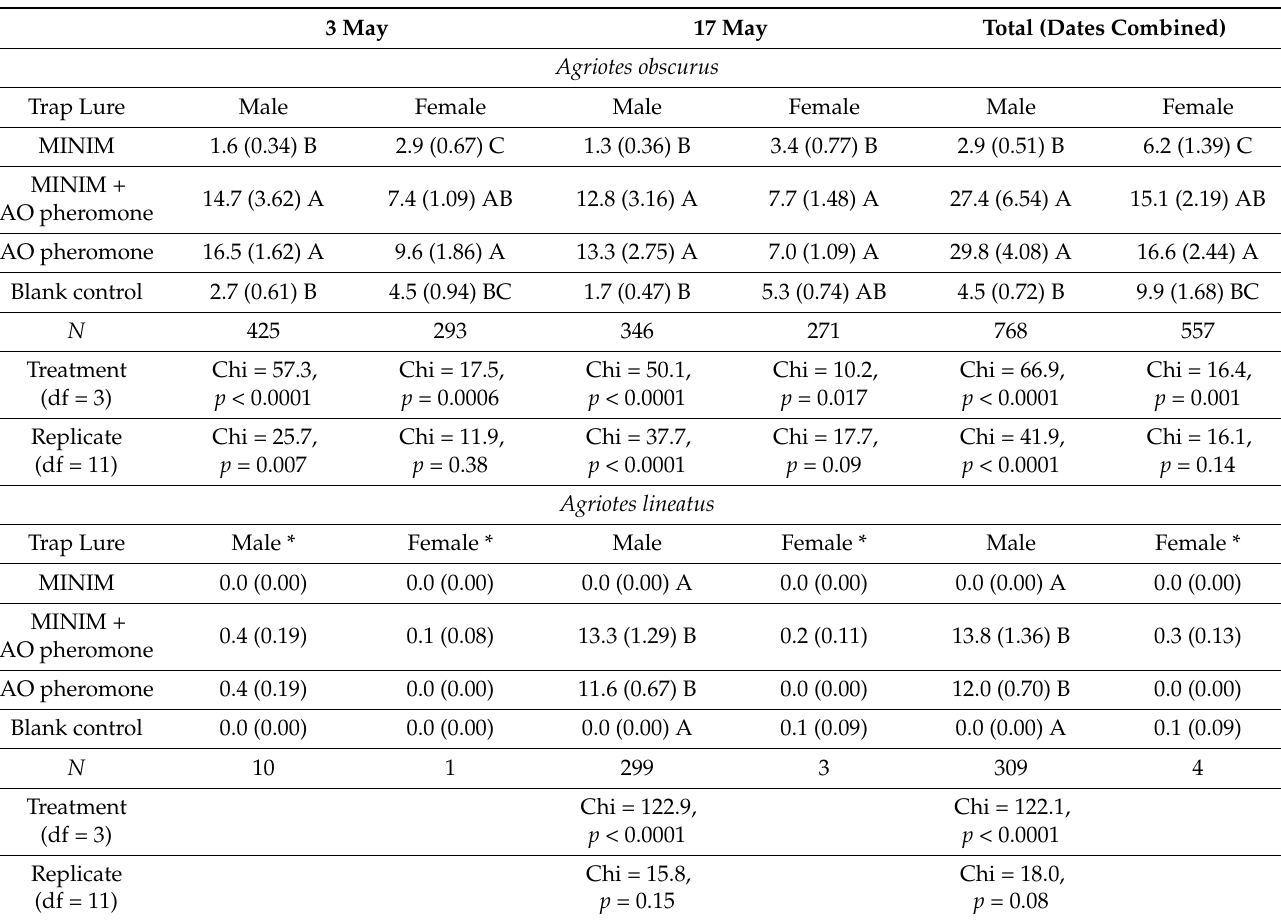
Table 1. Capture of Agriotes obscurus (AO) and A. lineatus (AL) male and female click beetles in traps baited with MINIM, a plant-derived attractant to A. brevis , and/or A. obscurus pheromone, in 2013. Shown are mean (SEM) numbers from 12 replicates. n = total beetles. For each species, numbers in columns followed by the same letter are not significantly different ( α = 0.05; Tukey’s HSD). The AL beetles were incidental bycatches in this study, which was principally designed to attract